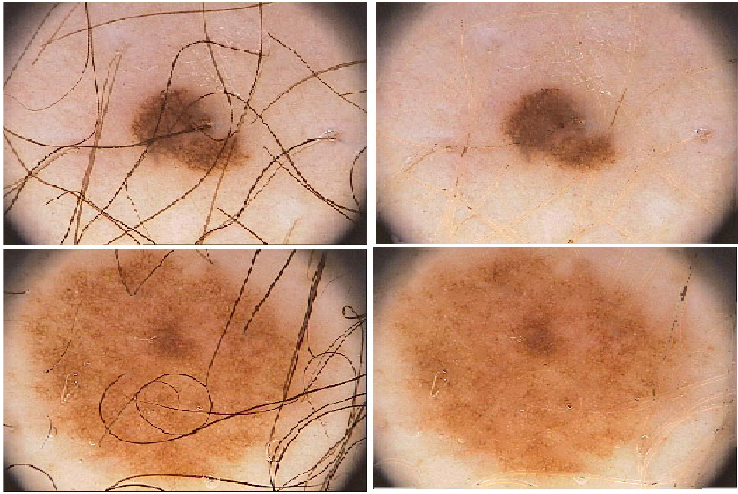
Figure 4. Sample dermoscopic images of skin lesions before and after hair removal.